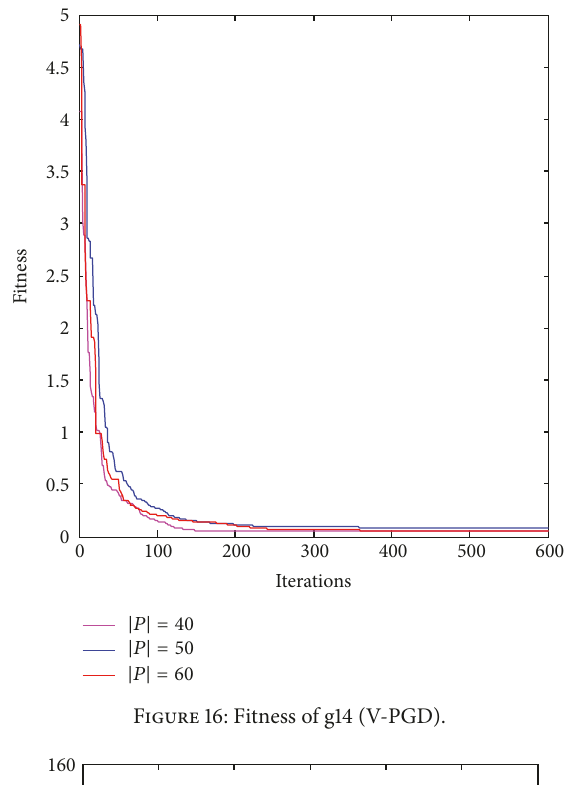
Figure 16: Fitness of g14 (V-PGD).